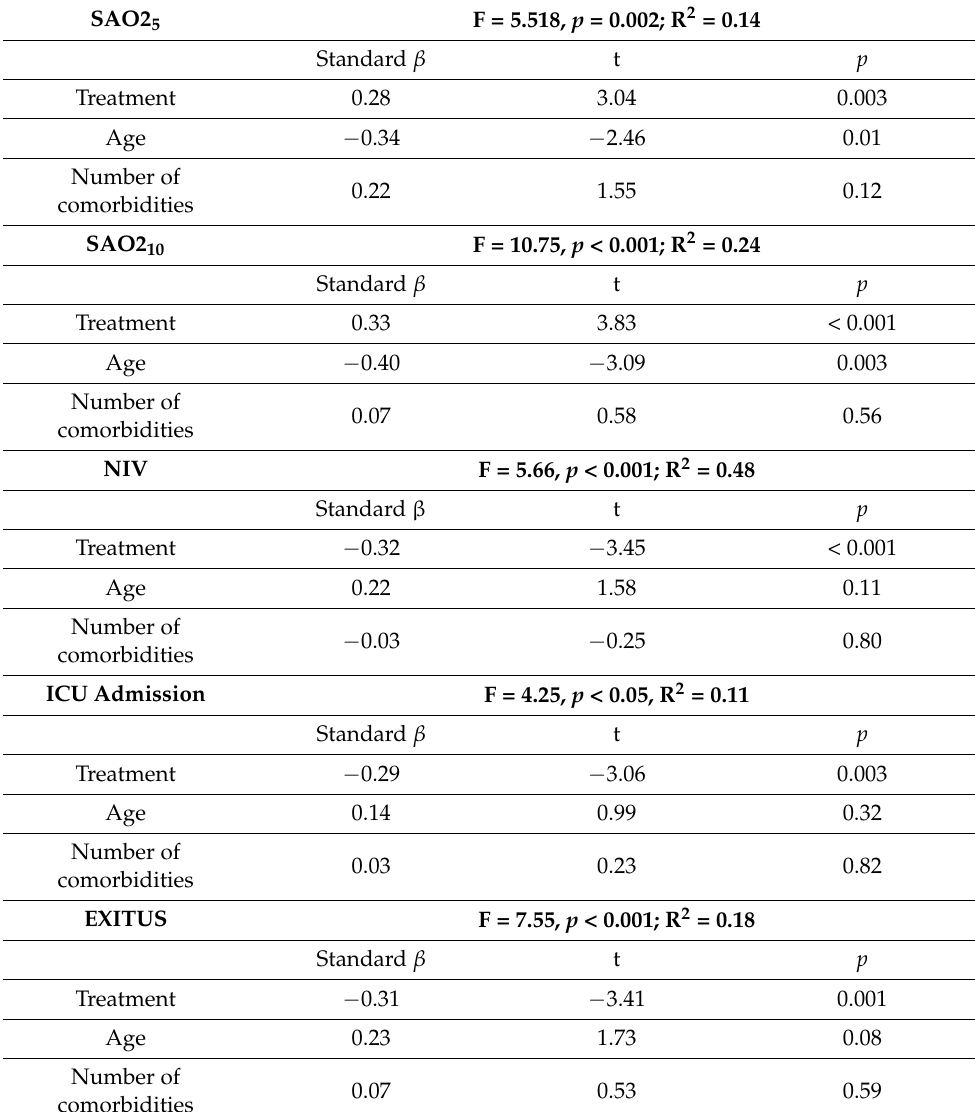
Table 3. Impact of treatment typology, age and number of comorbidities on SAO 2 at days five and ten, invasive care unit admission, and death. SAO2 5 F = 5.518, p = 0.002; R 2 = 0.14 Standard β t p Treatment 0.28 3.04 0.003 Age − 0.34 − 2.46 0.01 Number of 0.22 1.55 0.12 comorbidities SAO2 10 F = 10.75, p < 0.001; R 2 = 0.24 Standard β 0.33